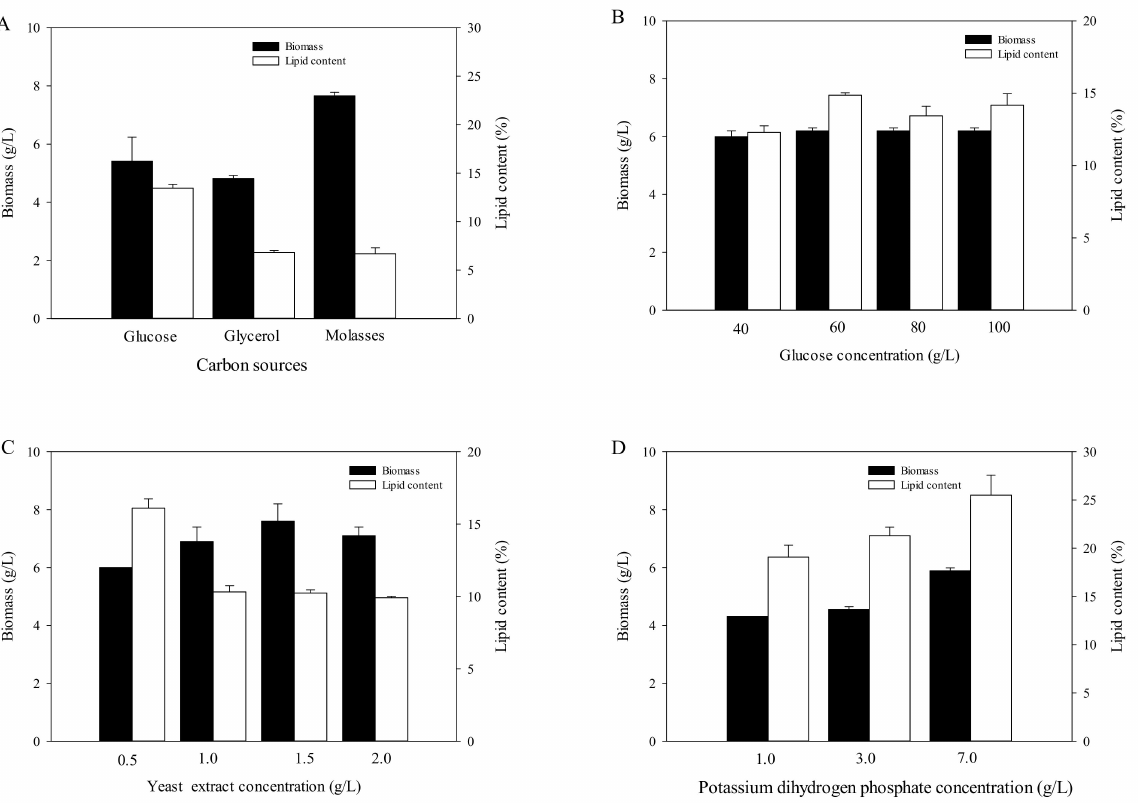
Figure 3. Optimization of the medium for R. mucilaginosa lipid production. Data are given as the mean SD, n = 3. ( A ) Impact of carbon sources on cell growth and lipid accumulation. ( B ) Lipid content and biomass of the yeast growth at different initial glucose concentration. ( C ) Lipid content and biomass of the yeast growth at different initial yeast extract concentration. ( D ) Lipid content and biomass of the yeast growth at different initial potassium dihydrogen phosphate